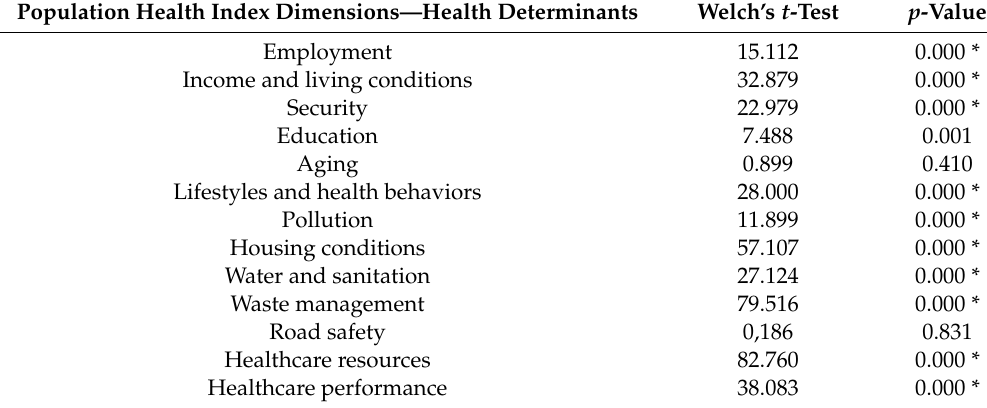
Table 3. ANOVA statistics by dimensional